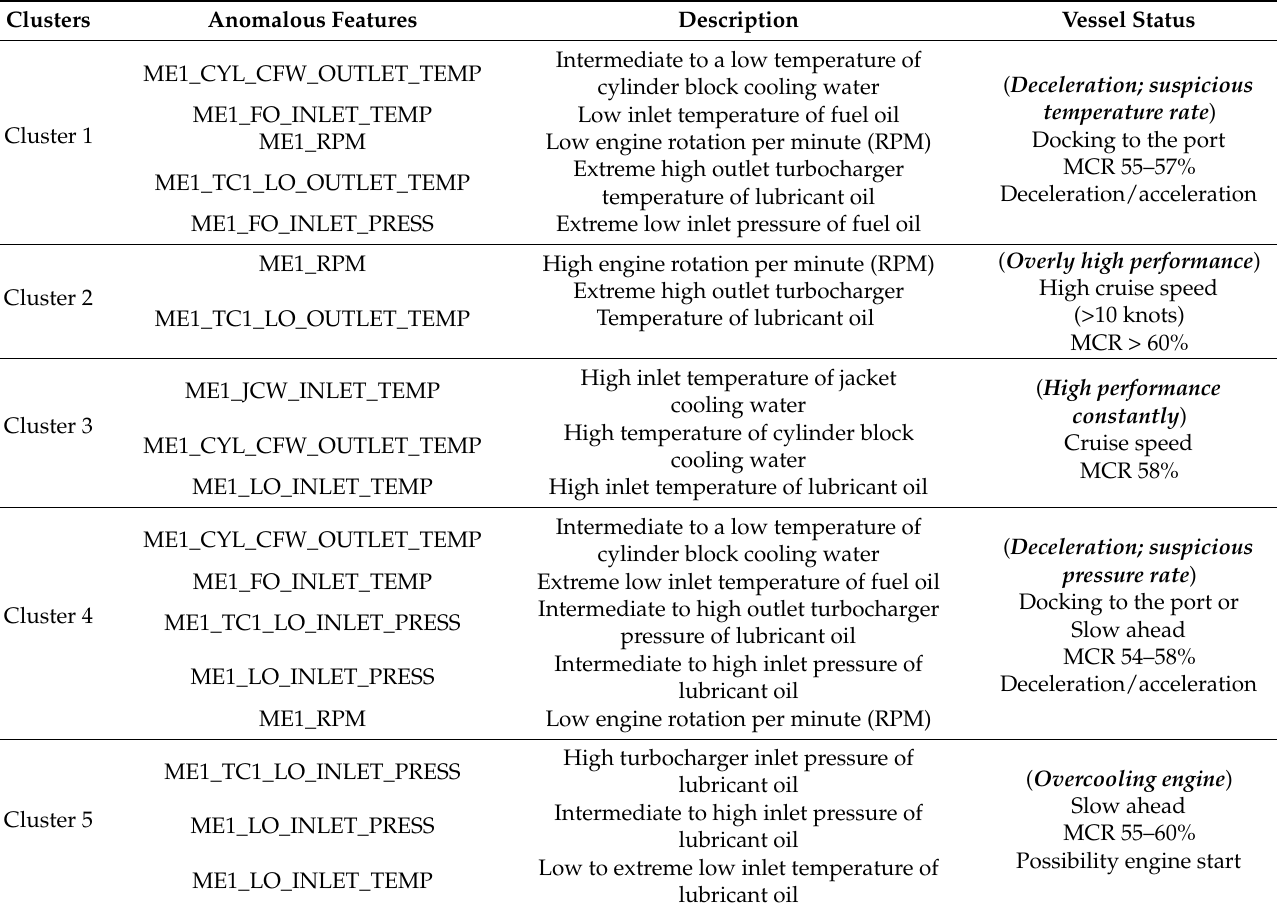
Table 5. Explanation of each cluster obtained from Figure